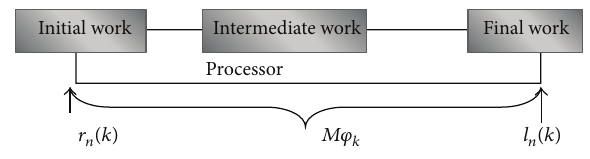
Figure 3: Work load of other tasks in work area 𝜑 𝑘